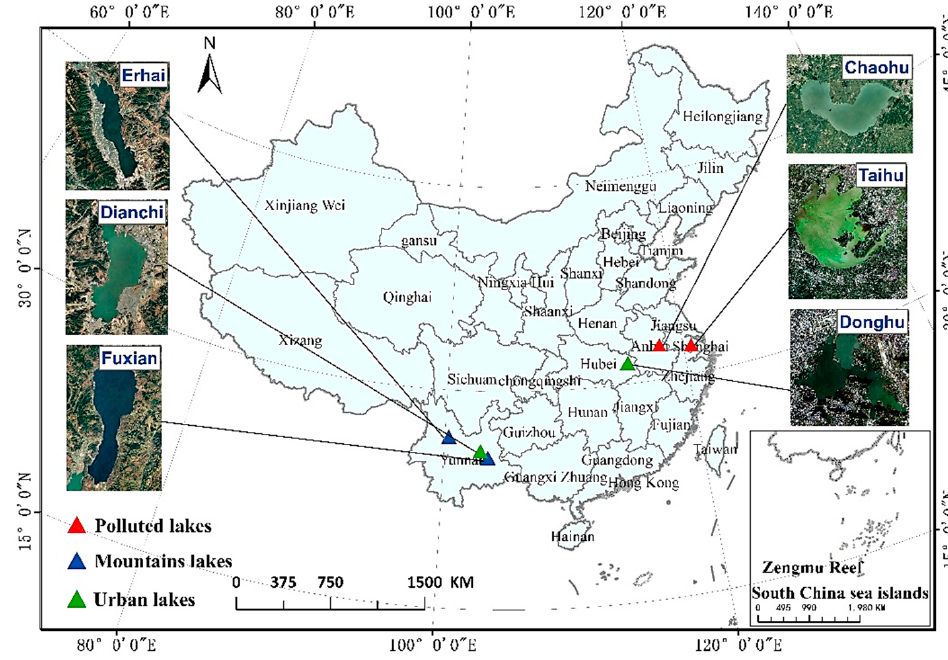
Figure 1. Geographic locations and optical imagery of the six lakes examined. The images shown are a false-color composite (Bands 8, 4, and 3) of Sentinel-2 MSI data.